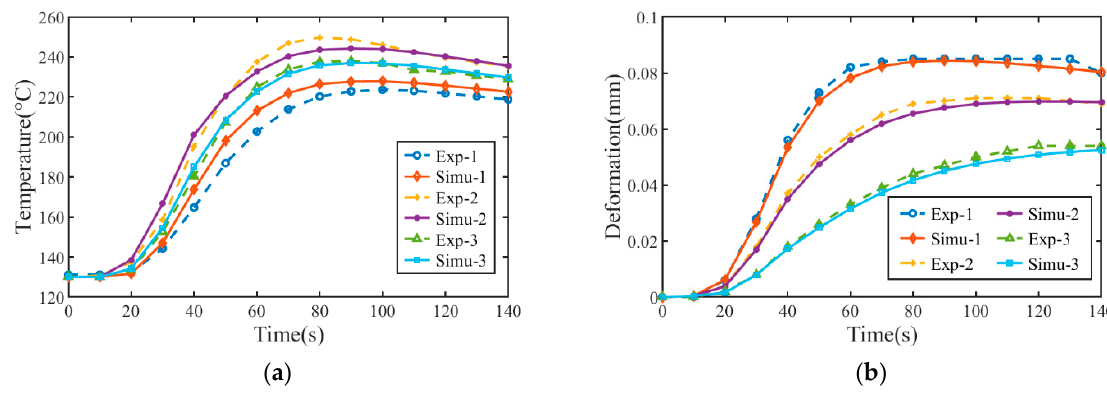
Figure 5. Comparisons between experiment and simulation of shot sleeve: ( a ) temperature; ( b ) deformation. In Figure 5, for both the temperature and deformation data, the trends between the experimental and simulated results are nearly consistent, and the errors are within a reasonable range, indicating the accuracy of the FE model. Simultaneously, the errors between the simulation and experimental data reflect the uncertainty of the injection process. It should be noted that the experimental and simulated temperature values at the measuring points do not show a sudden change. As the measuring points are not in direct contact with the molten metal but are located in the middle of the wall thickness of the shot sleeve, the measured temperature values rise slowly. Figure 6 shows the temperature and stress curve at the dangerous position of the shot sleeve. The dangerous position men- tioned here refers to the position where thermal fatigue was most likely to occur on the shot sleeve, as shown in Figure 7. In fact, for the surface of the shot sleeve that comes into contact with the molten metal first, the temperature will rise rapidly, so there will be a large temperature gradient and strong stress, as shown in Figure 6a. Therefore, the inner surface of the shot sleeve in contact with molten metal is a dangerous surface, and the point with the maximum Von Mises stress is a dangerous position, as shown in Figure 6b. After quenching and tempering, the yield strength of H13 should not be less than 800 MPa considering the temperature of the shot sleeve inner surface [8]. It was observed that the maximum stress did not exceed 500 MPa, which is lower than the yield strength of H13 steel, indicating elastic strain. By presetting different pouring temperatures and preheat- ing temperatures, the response values of the dangerous position of the shot sleeve were obtained by FE simulation, which could be used to build the Kriging model. ( a ) ( b ) Figure 6. Temperature and stress curve of dangerous position of shot sleeve: ( a ) temperature; ( b ) Von Mises stress.